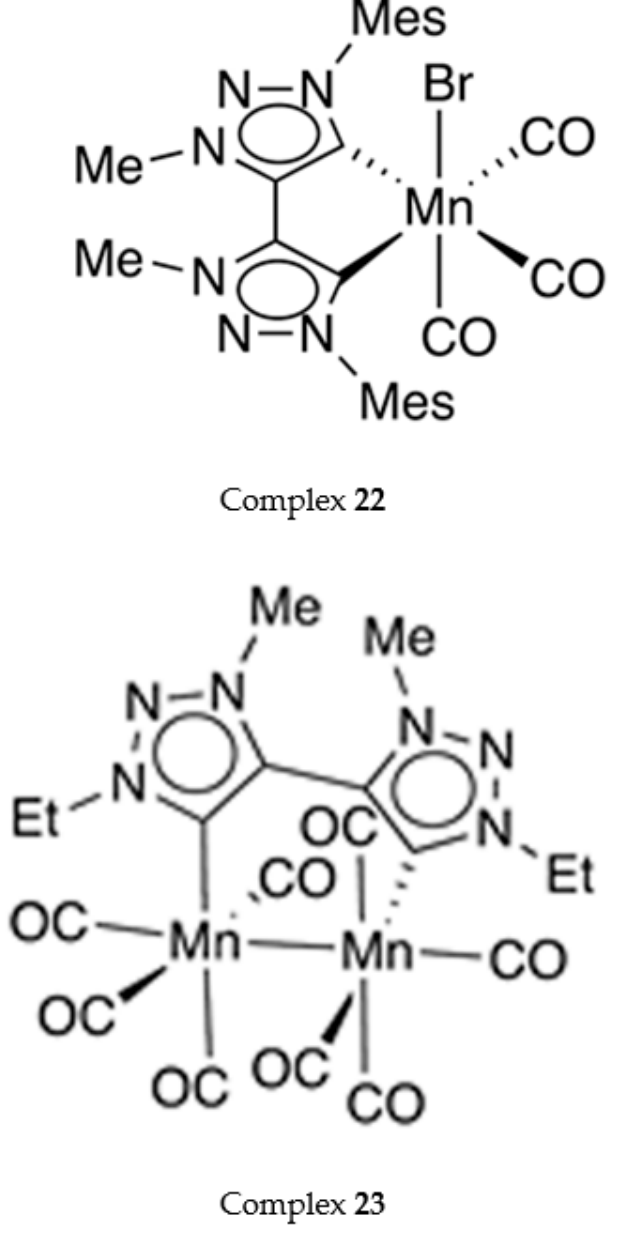
Figure 18. Carbonyl manganese compounds as a catalysts in oxidation with peroxides, Adapted from Ref. [99] Copyright (2019) with permission from Royal Society of